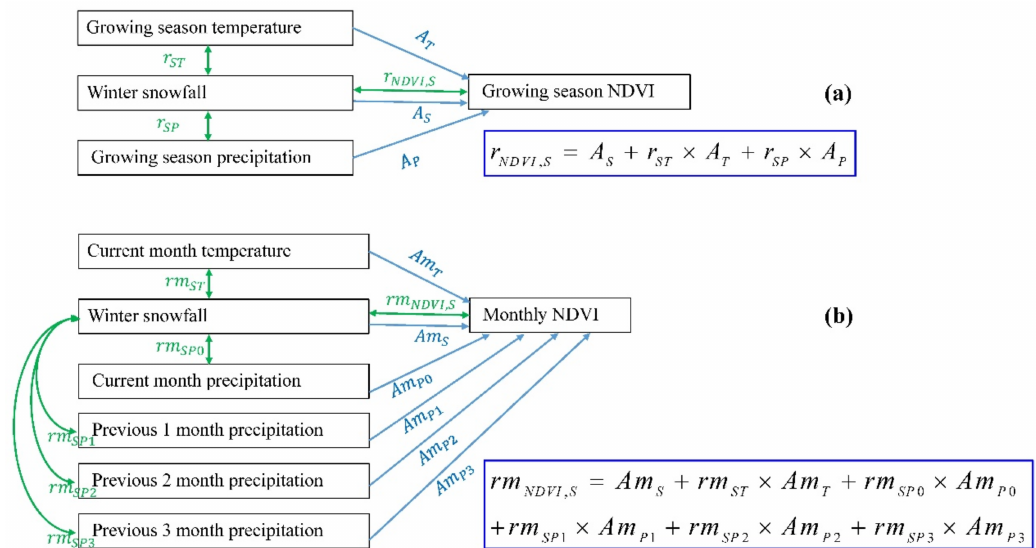
Figure 3. Path coefficient diagrams for growing season ( a ) and monthly ( b ) NDVI. A and r represent the direct path coefficient and Pearson correlation efficient, respectively. m represents parameters for monthly variables. S , T , and P represent winter snowfall, temperature, and precipitation, respectively. The subscripts P 1– P 3 indicate precipitation in the previous 1–3 months, and subscript P 0 indicates precipitation in the current